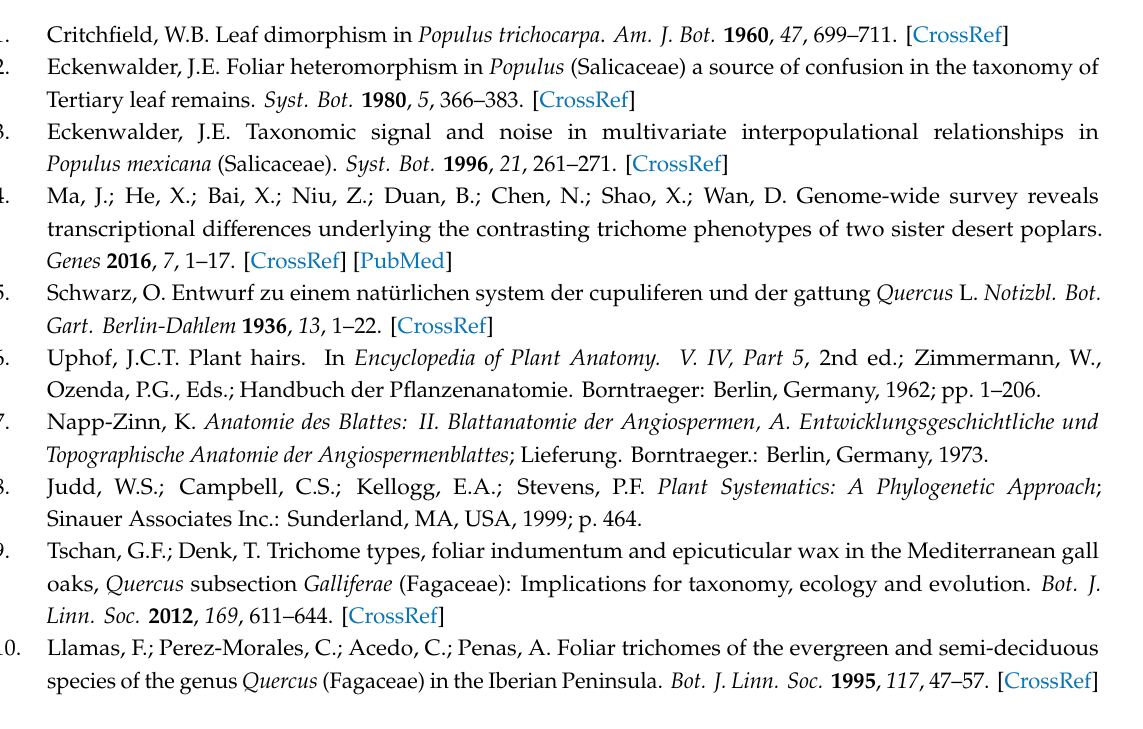
Table S1: Poplar trees samples, origin, collectors and Herbarium voucher location and number, Table S2: The used molecular markers and their characteristics, Figure S1: Marginal glands of P. nigra , Figure S2: Di ff erences in forms and lengths of glandular parts of P. nigra marginal glands, Figure S3: The external and internal structure of salicoid teeth of P. nigra , Figure S4: Leaves of P. nigra without basilaminar glands and with basilaminar glands, Figure S5: Trichomes on P. nigra leaves, Figure S6: Edge, basal part and petiole of P. deltoides ssp. deltoides leaves, Figure S7: Basilaminar glands, abaxial surface and petiole of P. deltoides ssp. deltoides leaves, Figure S8: The micromorphological features of P. deltoides ssp. moniliferae leaves, Figure S9: Trichomes of P. deltoides ssp. moniliferae leaves, Figure S10: The features of edge of P. × canadensis leaves, Figure S11: Glands and trichomes of P. × canadensis leaves, Figure S12: Types of leaf